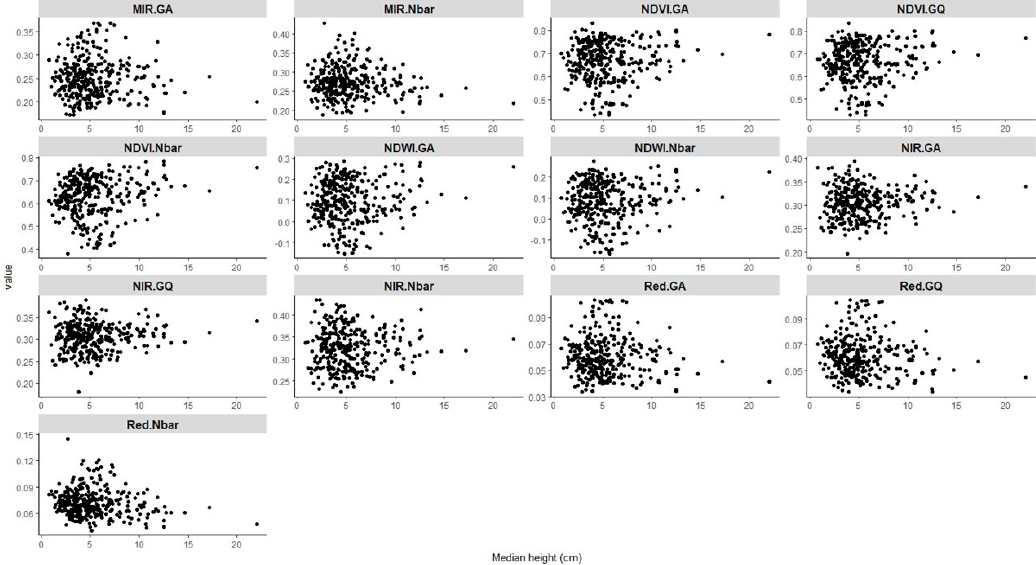
Figure 2. Scatterplot of median height (cm) in the x axes and MODIS satellite information in the y axes for all the analyzed paddocks. MIR: Middle infrared band, NIR: Near infrared band, Red: Red band, NDVI: Normalized difference vegetation index, EVI: Enhanced vegetation index. Nbar (MODIS/Terra and Aqua Nadir BRDF (bidirectional reflectance distribution function) adjusted reflectance (NBAR), 500 m), GA (MODIS Terra/Aqua Surface Reflectance 500 m), and GQ (MODIS Terra/Aqua Surface Reflectance 250 m) refer to the MODIS daily products analyzed.